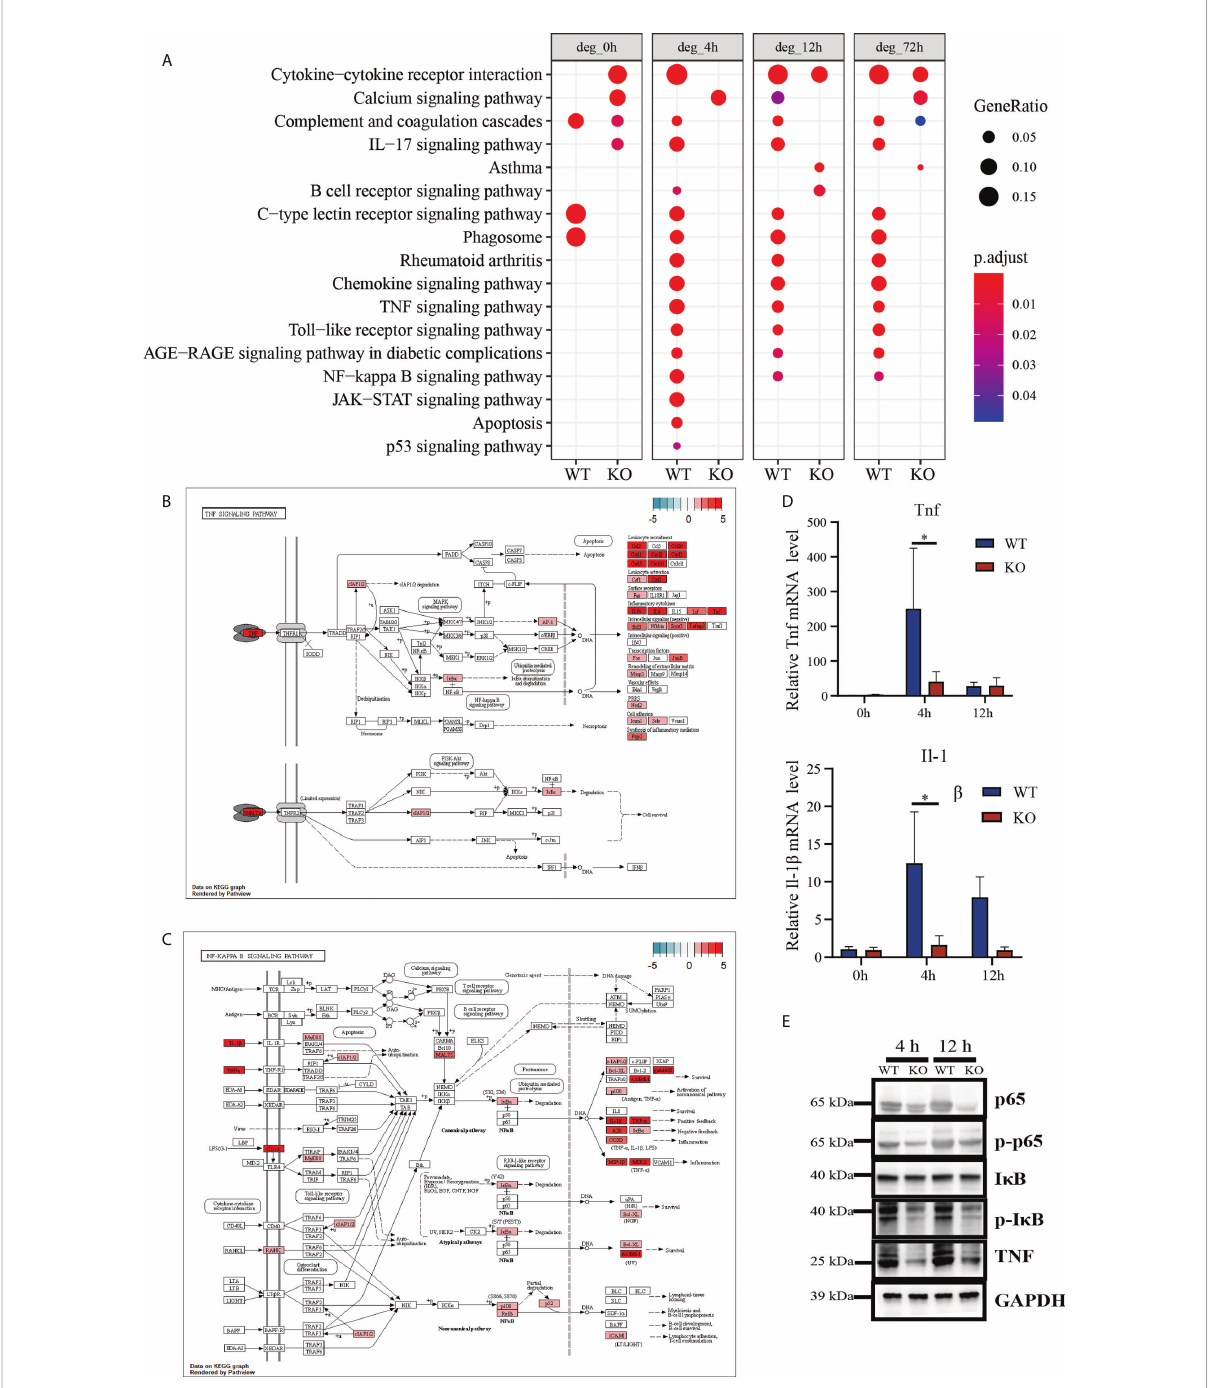
FIGURE 4 DEGs analysis of RNA-Seq in lung tissue of Csf2ra KO mice compared to WT mice at 4, 12 and 72 h post RT-inhalation. (A) The top 17 entries in the KEGG pathway of upregulated genes in Csf2ra KO mice or WT mice under different experimental conditions. (B) The TNF signaling pathway was signi fi cantly downregulated in Csf2ra KO mice relative to WT mice at 4 h post-RT inhalation. (C) The NF- k B pathway was signi fi cantly downregulated in Csf2ra KO mice relative to WT mice at 4 h post-inhalation. (D) RT-qPCR veri fi cation of genes identi fi ed in transcriptome analysis. Two-way ANOVAs followed by Sidak ’ s multiple comparison tests were used; *P <0.05. (E) Western blot analysis for p-p65, p65, p-I k B, I k B and TNF protein expression